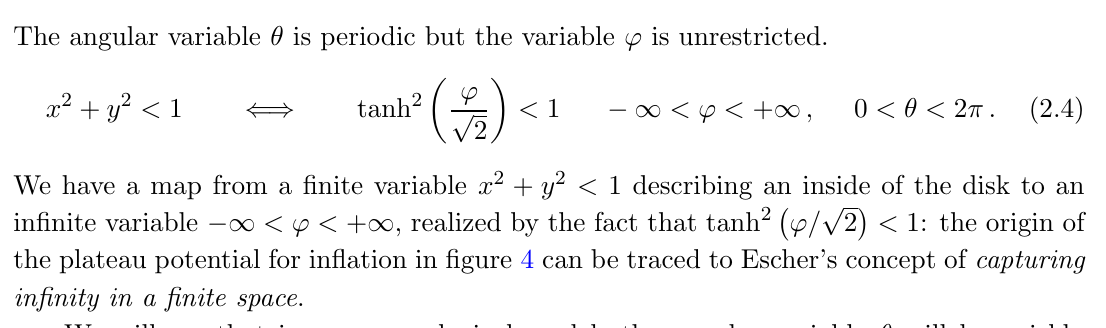
p (cid:0) (cid:1) ’= 2